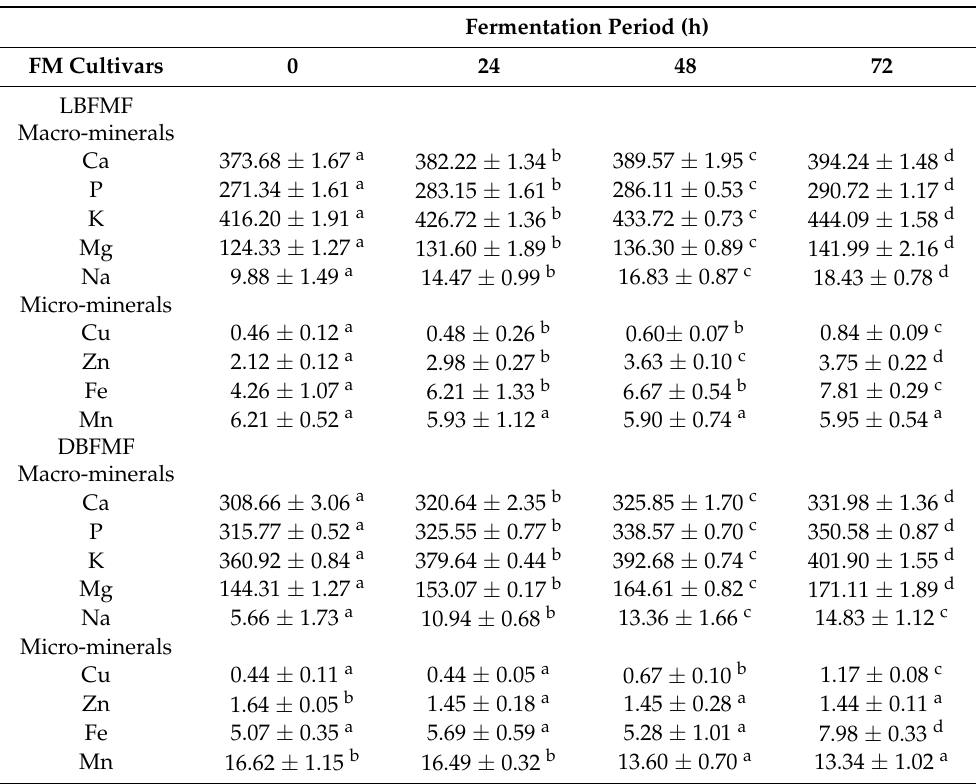
Table 1. Impact of spontaneous fermentation on macro and micro-minerals of finger millet flours (mg/100 g dry